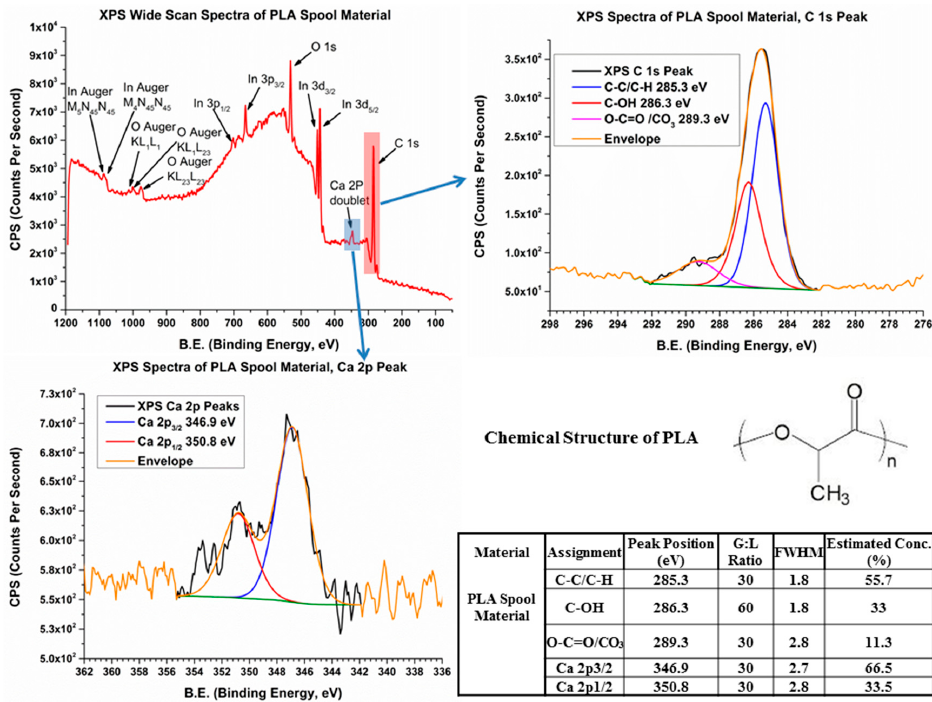
Figure 9. XPS spectra of PLA spool material as received, showing the wide-scan spectra and analysis of the C 1s and Ca 2p photoelectron peaks.